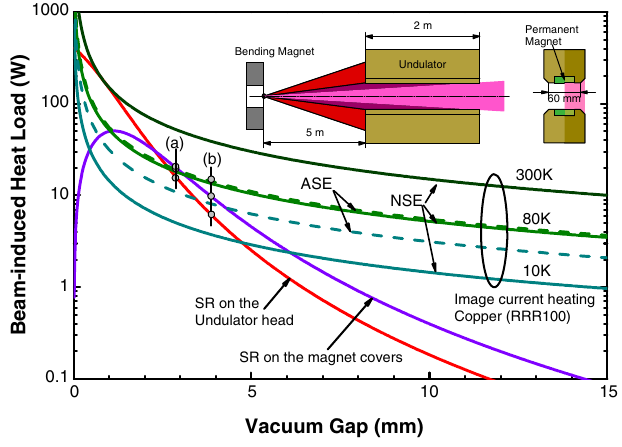
FIG. 9. Dependence of the beam-induced heat load on the vacuum gap in an IVU/CPMU. The red/purple curves denote the heat load due to SR on the undulator head/magnet covers, respectively. Heat load derived from indirect SR is not consid- ered. The solid/dashed green curves denote the heat load due to image current heating under the assumption of normal/anomalous skin effect, respectively. The lines (a) and (b) indicate the CPMU (TPS-CU15) at its smallest gap and the gap during commission- ing stage, respectively. The calculation is based on TPS param- ¼ 3 GeV, I ¼ 500 mA, number of bunches ¼ 600 , eters, E b GeV bunch length ¼ 4 . 65 mm (15.5 psec), circumference ¼ 518 m, bending radius ¼ 8 . 353 m and a distance of 5 m from the dipole magnet end to the undulator